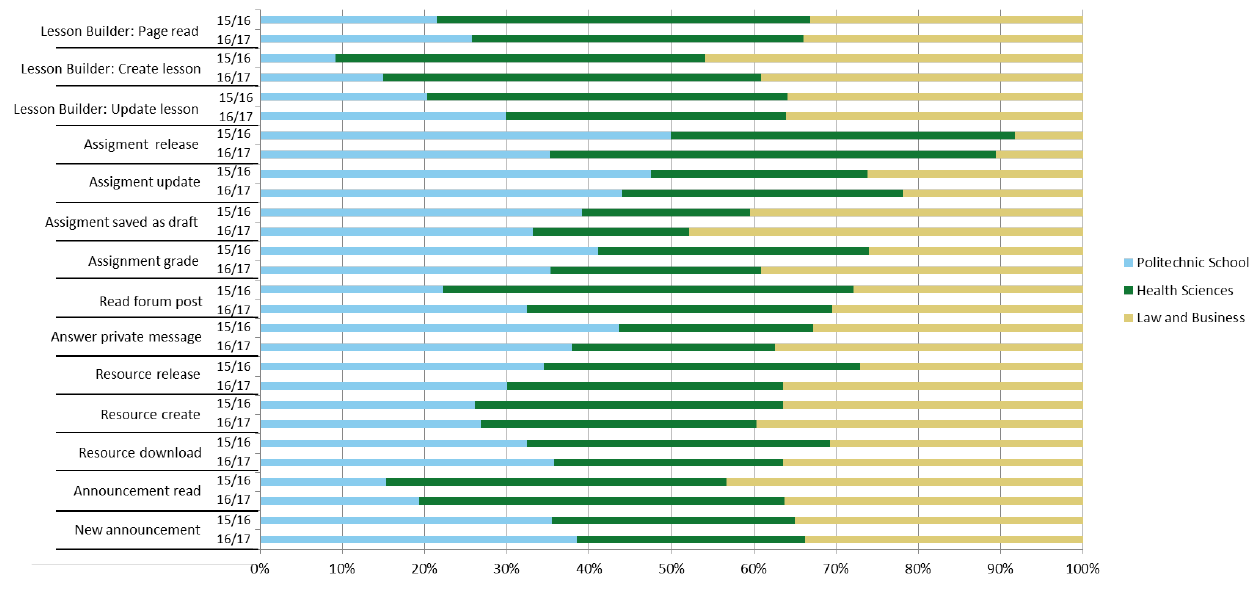
Figure 3. Ranking of events per lecturer (in percentage) related to the online modality for the academic years 2015/16 and 2016/17. Note that only faculties with online degrees are